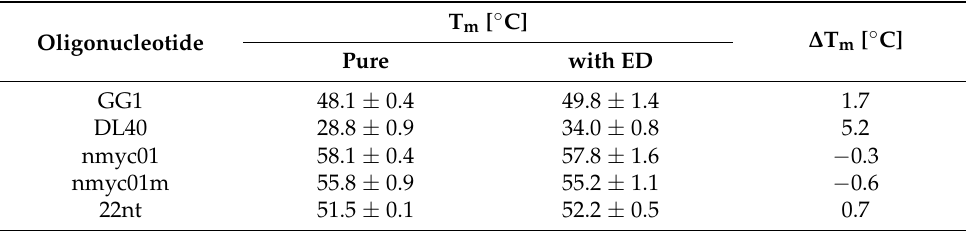
Table 2. T m values of pure oligonucleotides and